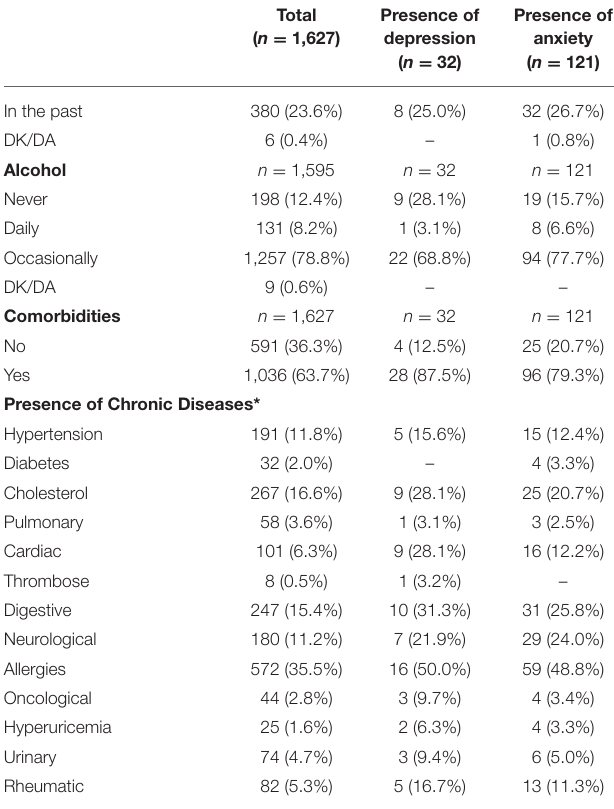
TABLE 4 | Sociodemographic and health-related characterisation of NOVA University subjects, stratified based on mental health assessment